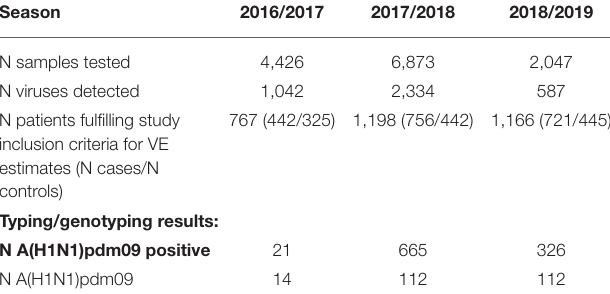
N patients fulfilling study inclusion criteria for VE estimates (N cases/N